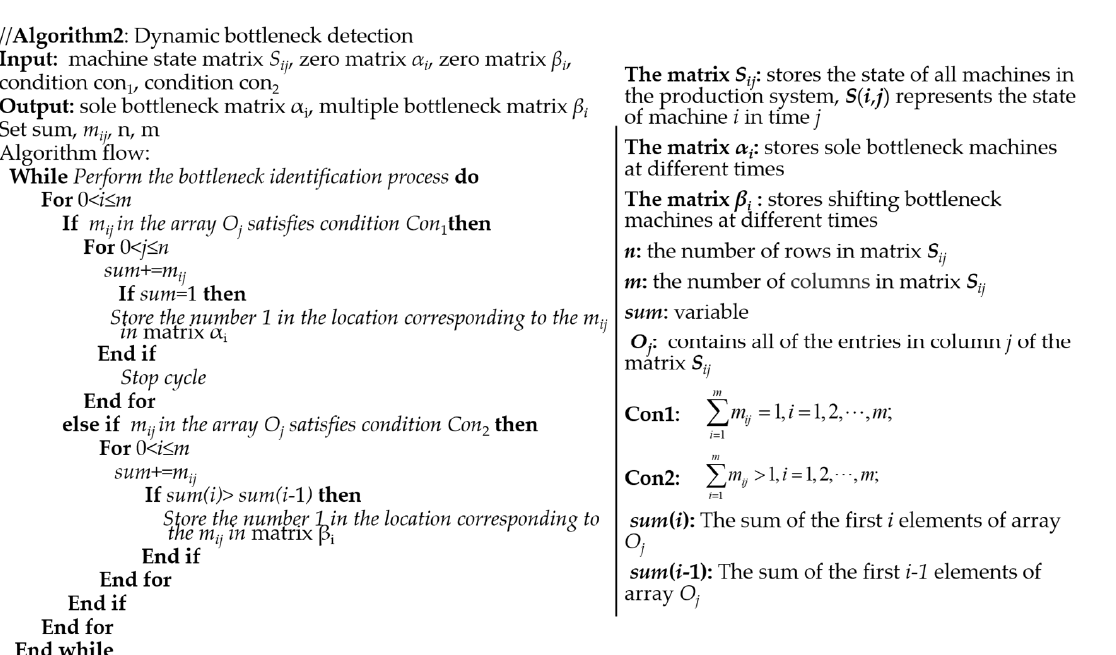
Figure 7. The dynamic bottleneck recognition algorithm.